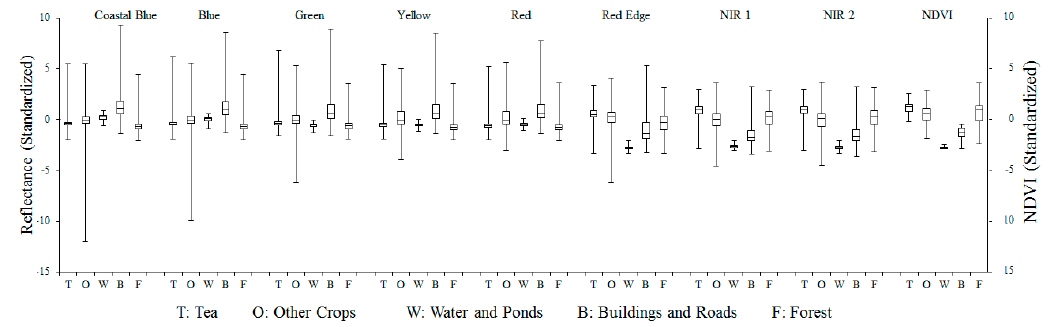
Figure 4. Distribution of standardized reflectance of different LULC across 8 multi-spectral bands and NDVI.